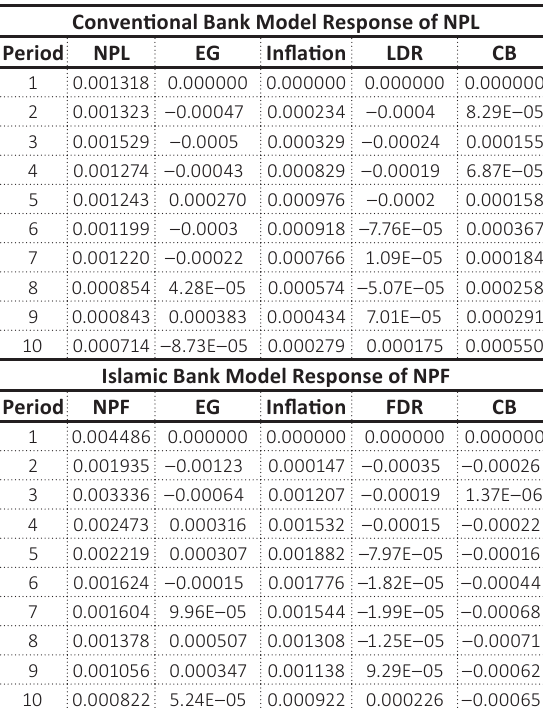
Table 1. IRF estimation